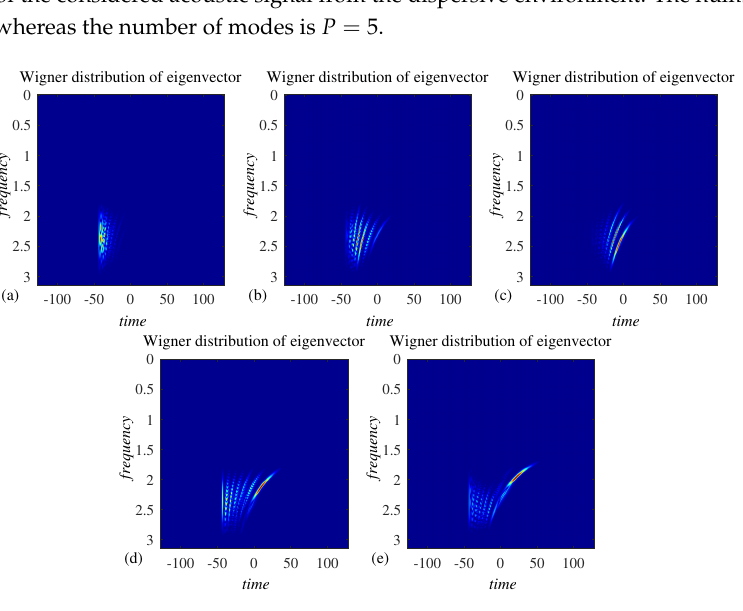
Figure 16. ( a – e ) Time-frequency representations of eigenvectors corresponding to the largest eigen- values of autocorrelation matrix R . Each eigenvector represents a linear combination of acoustic modes of the signal received from the dispersive environment.